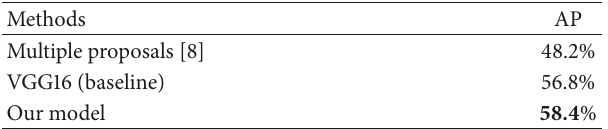
Table 2: The Average Precision (AP) on the Oxford Hand Detection Dataset and comparison with previous methods. Only large hand instances (larger than a fixed area of bounding box) are considered in the